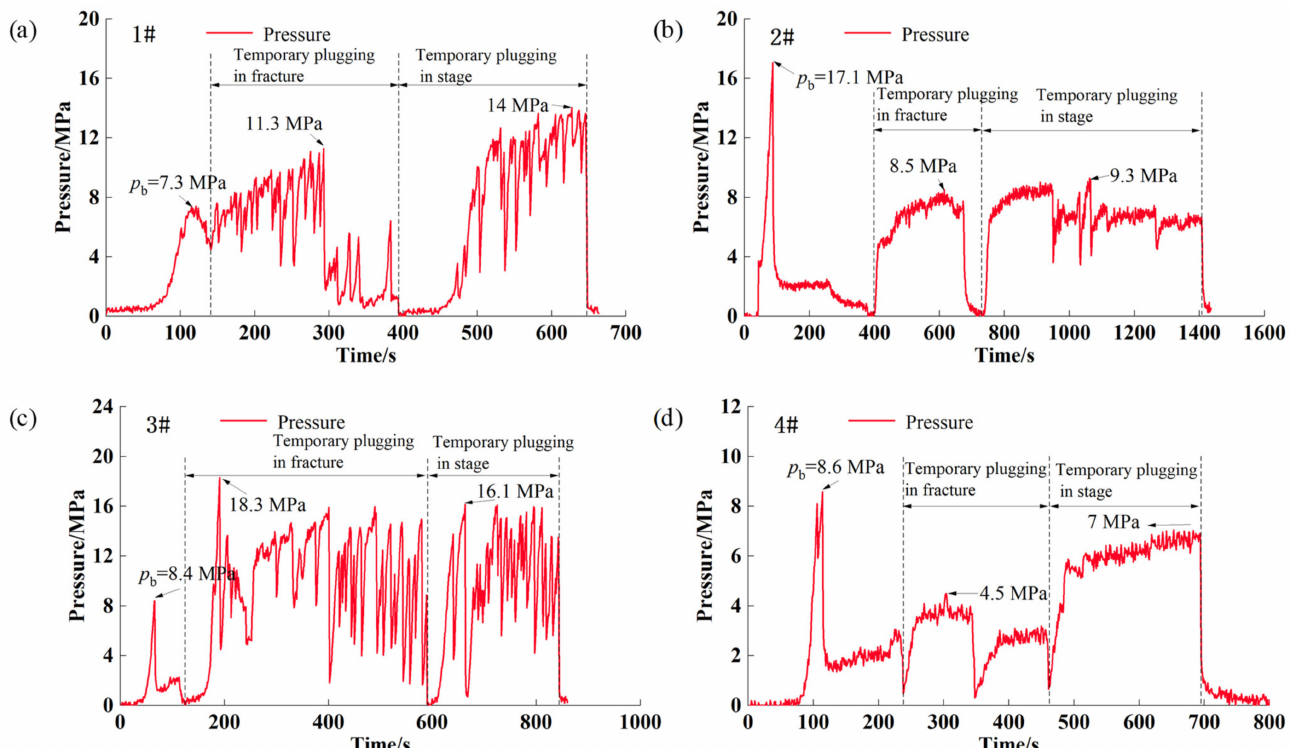
Figure 6. Temporary plugging pressure curve under different particle size combinations of temporary plugging agents: ( a ) Pressure curve of specimen 1#, ( b ) Pressure curve of specimen 2#, ( c ) Pressure curve of specimen 3#, ( d ) Pressure curve of specimen